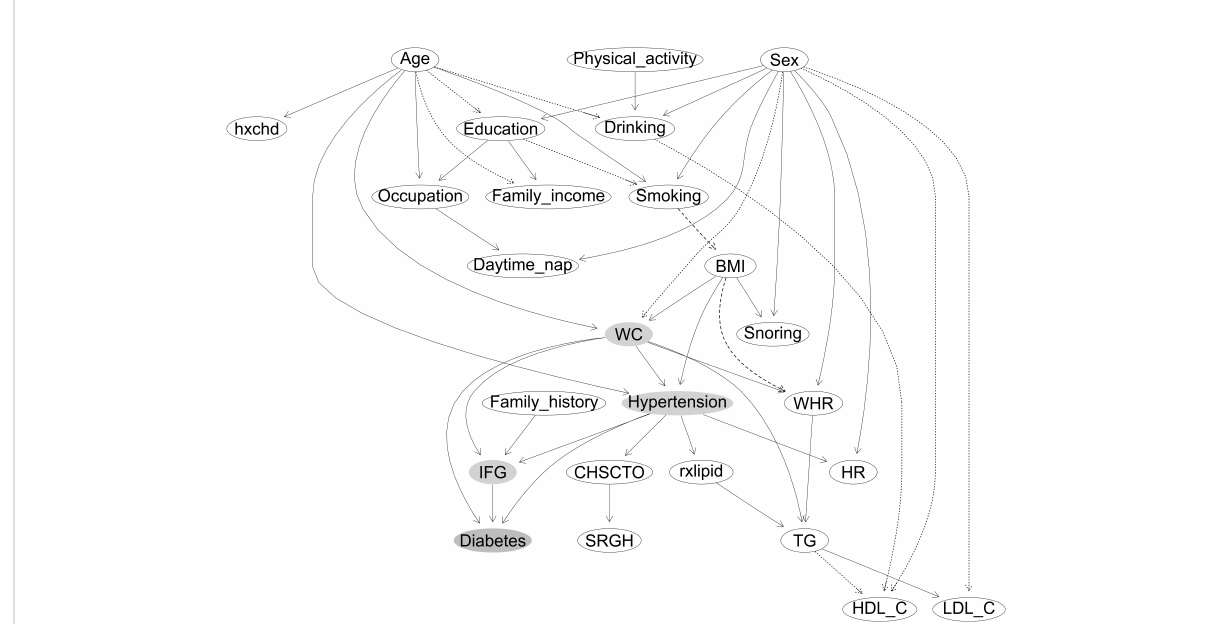
FIGURE 2 The constructed Bayesian network model of new-onset diabetes. (1) Labeled ovals represent nodes; arrows (arcs) represent (likely) causal relationships. Node in orange represents the deterministic node, and nodes in blue represent the nodes in the Markov blanket of the deterministic node. Arcs between the nodes with solid lines indicate positive association, and dotted line indicates negative associations. Arcs between the nodes with dashed lines indicate that, compared with the never smokers, former smokers had a higher probability of having greater BMI, whereas current smokers had a lower probability. Compared with those with BMI low than 25 kg/m 2 , participants with BMI above 25 and less than 30 kg/m 2 had a higher probability of having greater WHR, whereas those with BMI above 30 kg/m 2 had a lower probability. (2) Variables considered and/or tested were based on previous studies in the literature and data available in the present study, as follows: sex; age; education; occupation; family income; smoking; drinking; physical activity; daytime nap, daytime napping; snoring; CHSCTO, current health status compared with others; SRGN, self- reported general health; hypertension; HR, heat rate; rxlipid, lipid lowering drugs; hxchd, self-reported coronary heart disease; family history, family history of diabetes; BMI, body mass index; WC, waist circumference; WHR, waist-to-hip ratio; TG, triglycerides; HDL-C, high-density lipoprotein- cholesterol; LDL-C, low-density lipoprotein cholesterol; IFG, impaired fasting